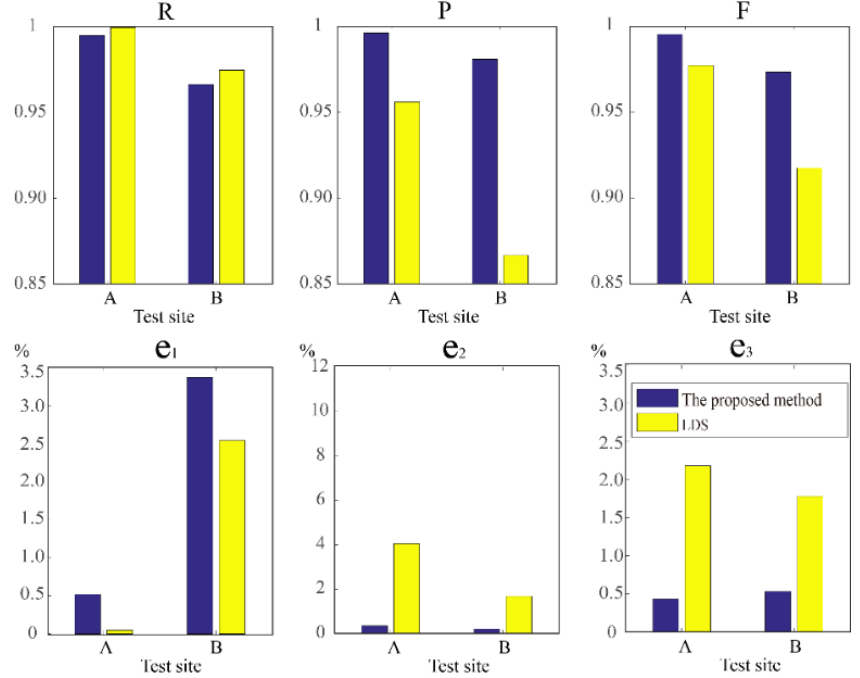
Figure 9. Accuracy assessment indicators and error indices corresponding to the results of the LDS method and the proposed method.